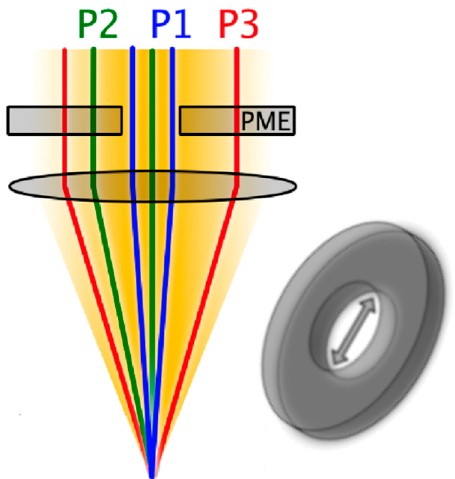
Figure 3. The PME introduces three potential optical pathlengths. Light mapped to Pathlength 1 (P1, blue) travels through the center of the PME to and from the retina. Light mapped to Pathlength 2 (P2, green) travels through the PME central aperture only once—travelling either to or from the retina. Light mapped to Pathlength 3 (P3, red) does not travels through the PME central aperture—both to and from the retina. Permission was granted by the publisher to reprint this figure from Gardner et al. with minor modifications [19].